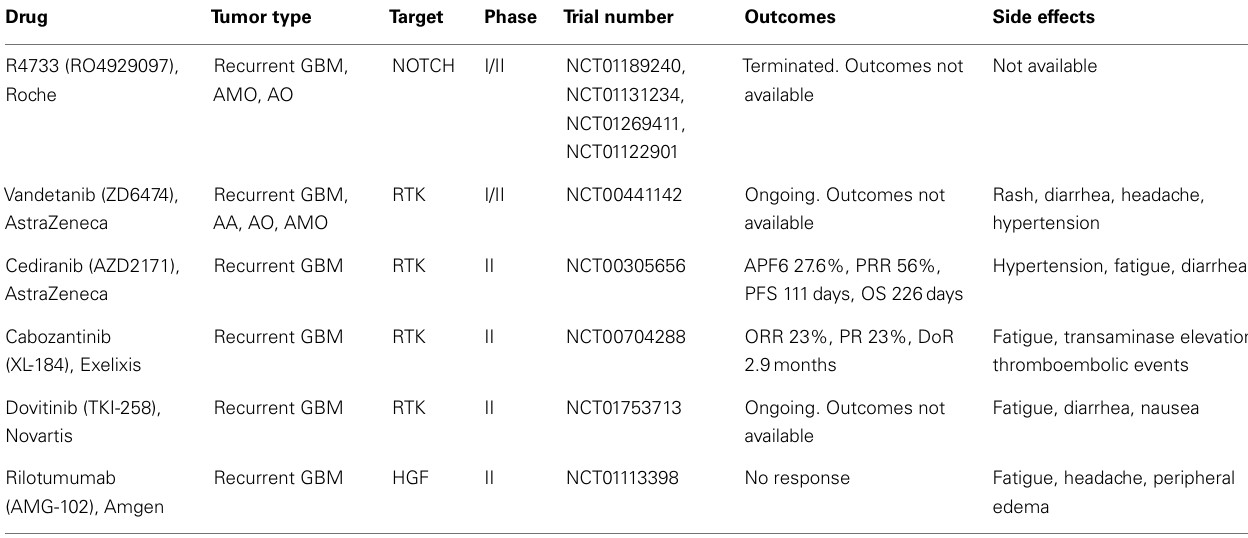
Table 1 | Clinical trials of GBM targeting c-MET or